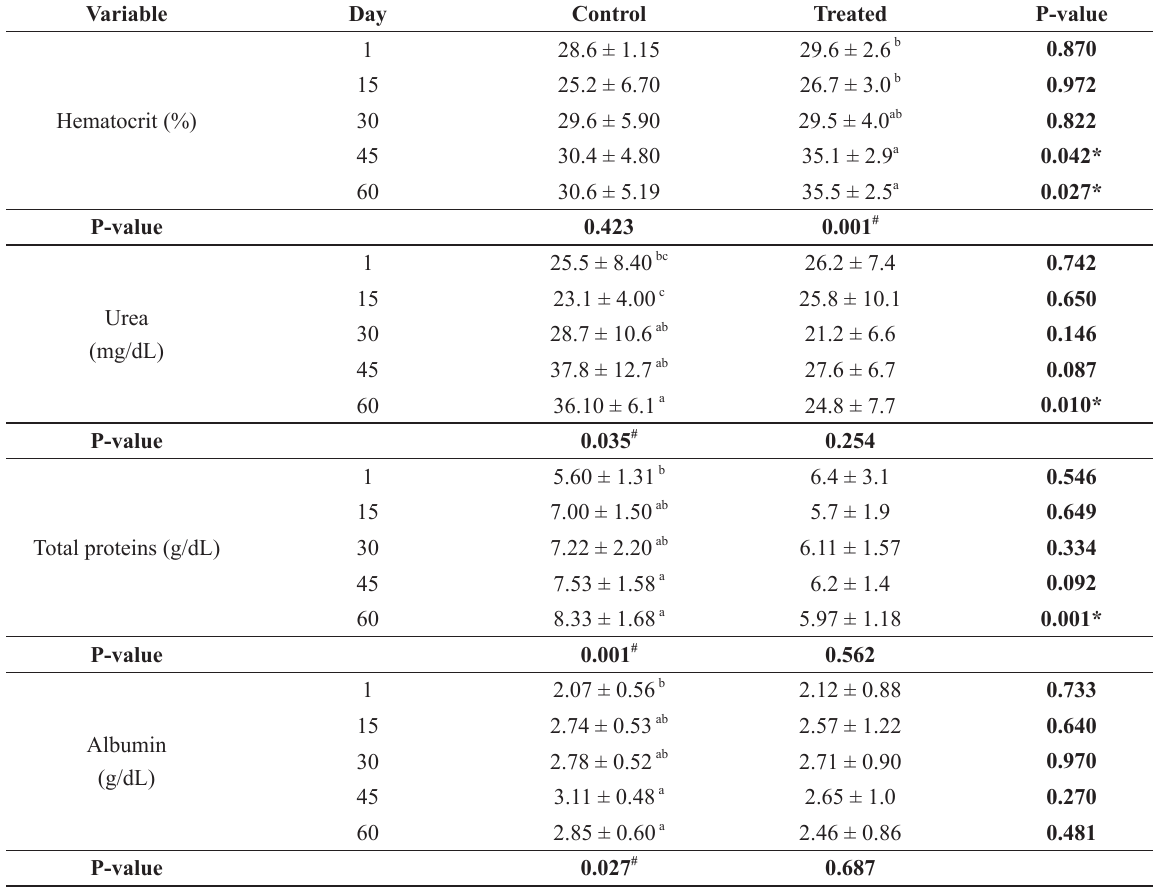
Hematocrit (total blood), urea, total proteins, albumin, globulins, glucose, triglycerides and cholesterol in serum of calves not treated (control) and treated with essential